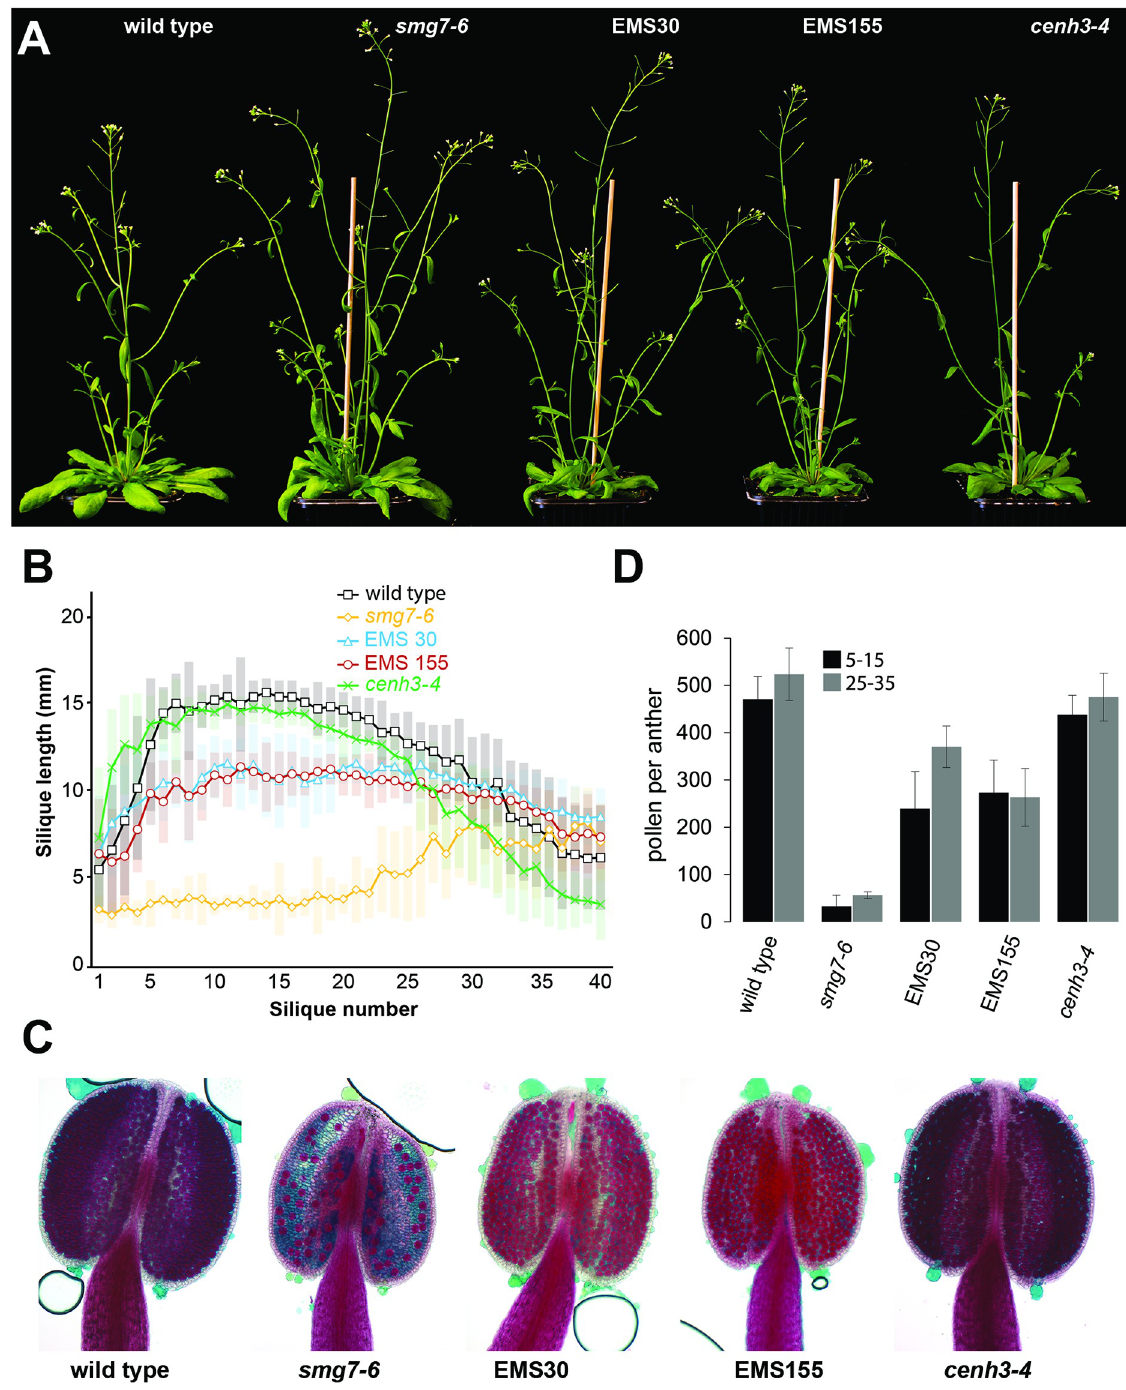
Fig 4. Characterization of the EMS30 and EMS155 suppressor lines. (A) Five week-old plants of indicated genotypes. (B) Analysis of silique length along the main inflorescence bolt in wild type (n = 16), smg7-6 (n = 15), EMS30 (n = 16), EMS155 (n = 15) and cenh3-4 (n = 16) plants. Position 1 corresponds to the oldest and position 40 to the youngest silique scored on the main bolt. Error bars represent standard deviations. (C) Anthers of indicated lines after Alexander staining. (D) Number of viable pollen per anther from flowers at positions 5–15 and 25–35 along the main inflorescence bolt. Error bars represent standard deviations (n =